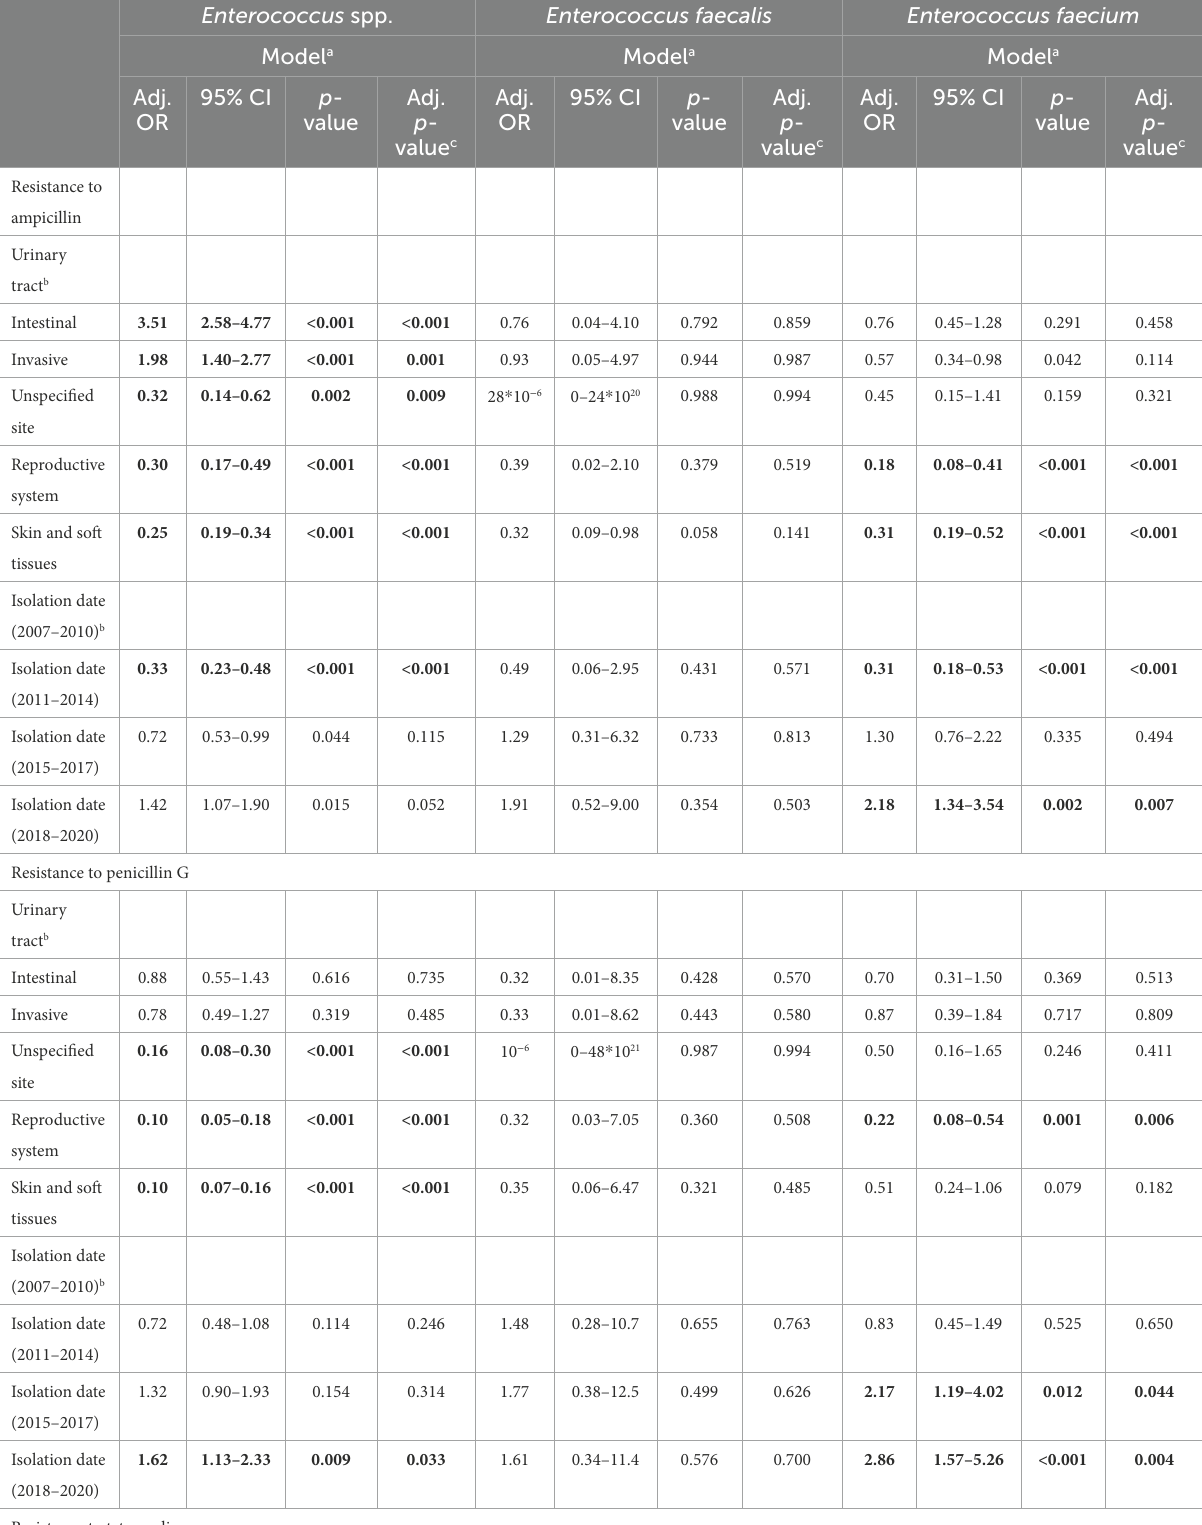
TABLE 3 Determinants of resistance to the common antimicrobials including specimen source and study period among Enterococcus spp. isolates using multivariable logistic regression models, in canine clinical infections at the Cornell University Animal Health Diagnostic Center